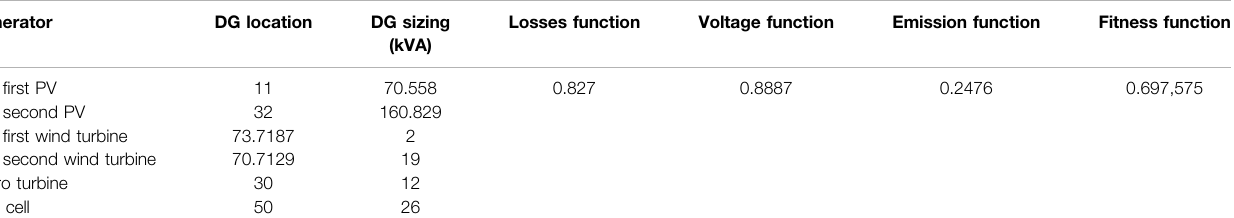
TABLE 2 | Optimization results of